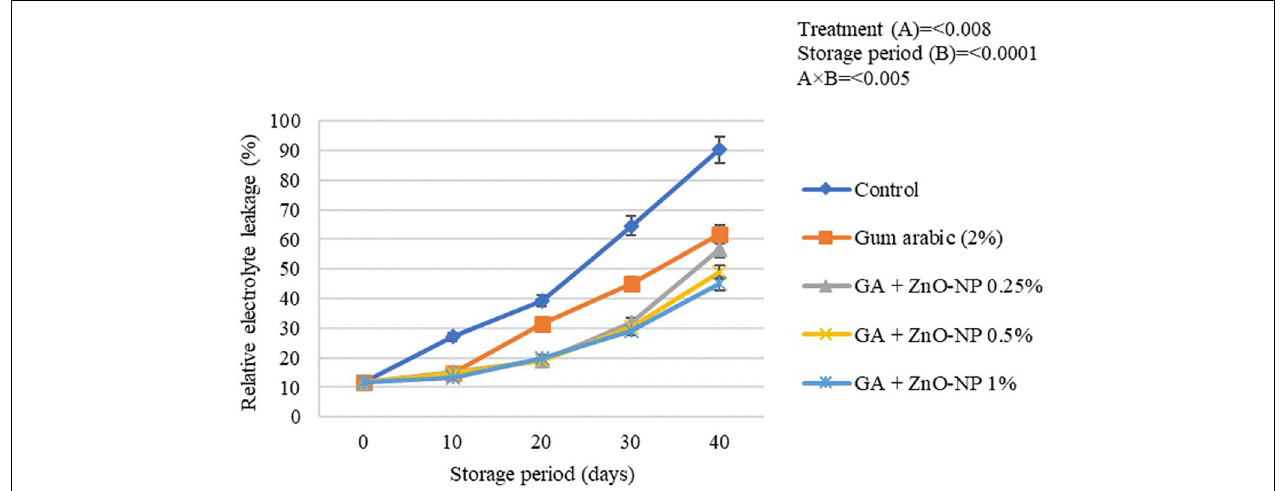
FIGURE 7 | Relative electrolyte leakage of ‘Kinnow’ mandarin fruit during storage for 40 days at 5 ± 1 ◦ C. Error bars denote the standard error (SE) of the mean. Means ± standard errors presented. To determine the interaction effects, factorial ANOVA was performed for the main factors, treatment, and storage time. GA + ZnO-NP, gum arabic + zinc oxide